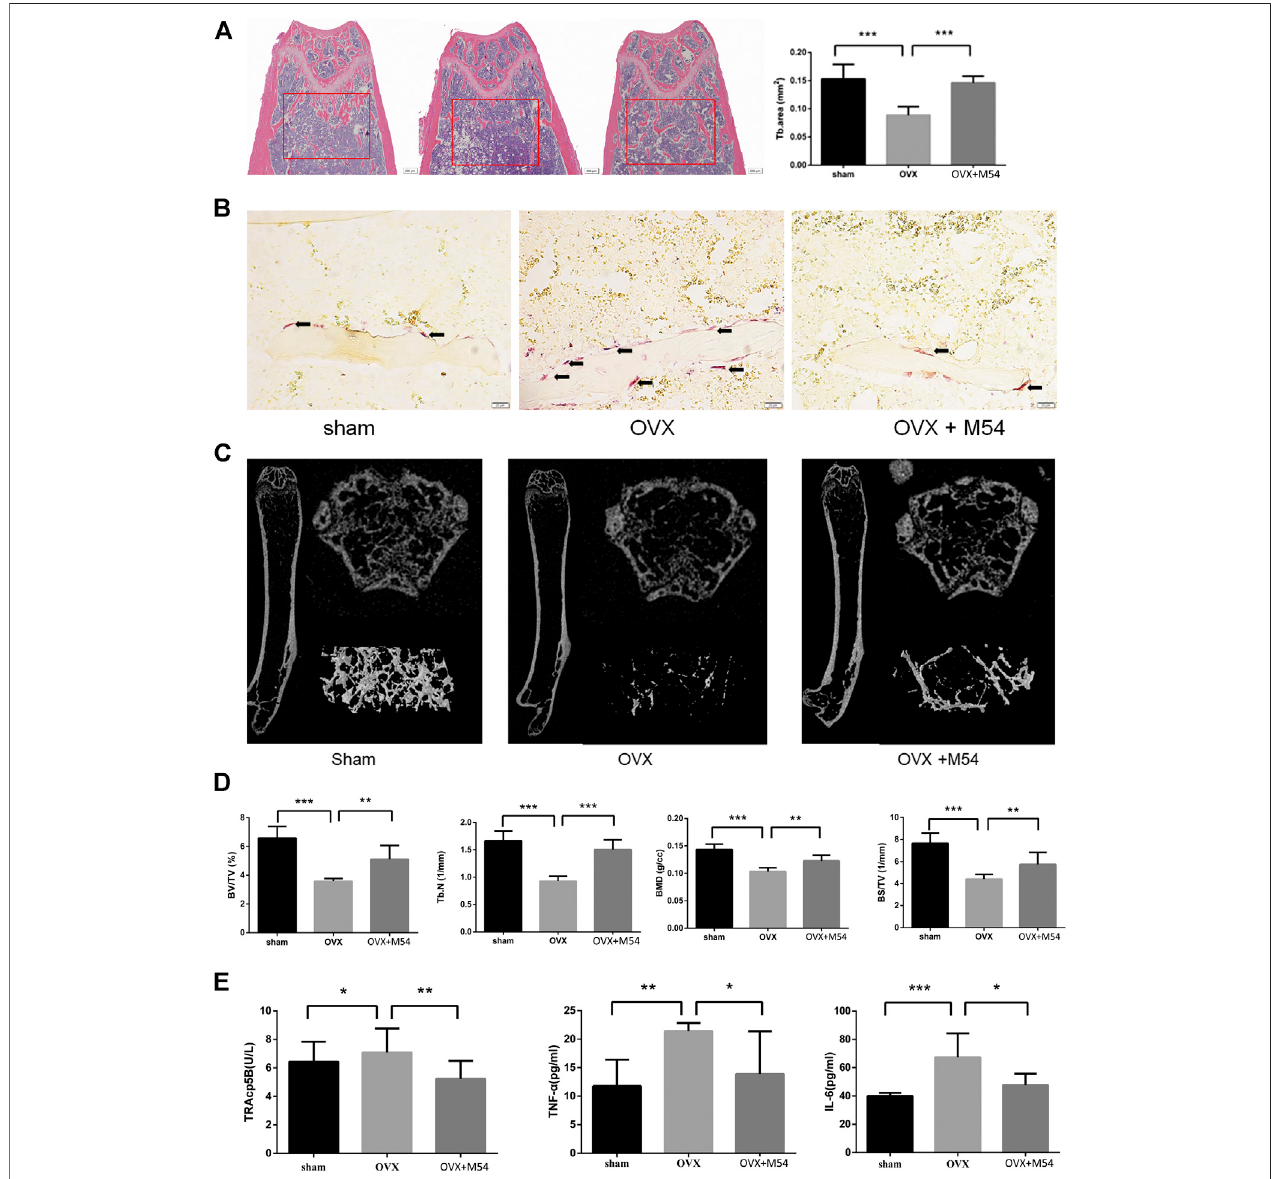
FIGURE 6 | M54 prevents ovariectomy-induced bone loss in vivo. (A) Representative H&E staining of distal femoral sections and quanti fi cation of trabecular area from each group 6 week after the operation ( × 40). (B) Representative TRAP-stained histologic distal femur sections from sham, OVX and OVX + M54 group ( × 400). (C) MicroCTanalysisofthedistal femurfrom sham, OVX,and OVX+M54group. (D) Calculationsofbonevalue/totalvalue(BV/TV), trabecular number (Tb.N), bonemineral density (BMD), and bone surface area/total value (BS/TV). (E) Serum TRAcp5B, TNF- α , and IL-6 were examined ( p p < 0.05, pp p < 0.01, ppp p < 0.001).